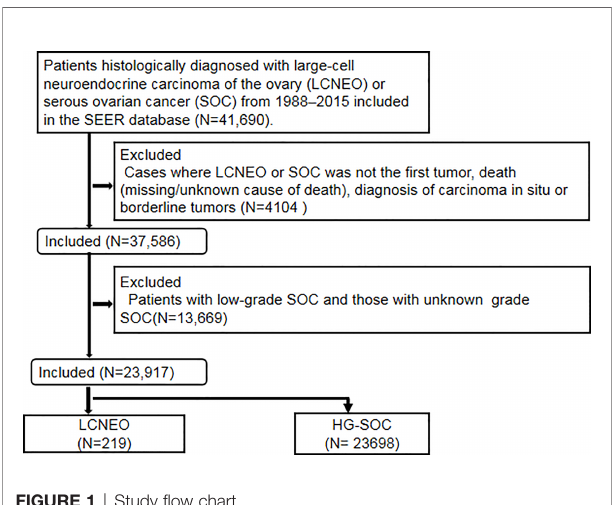
FIGURE 1 | Study fl ow chart.